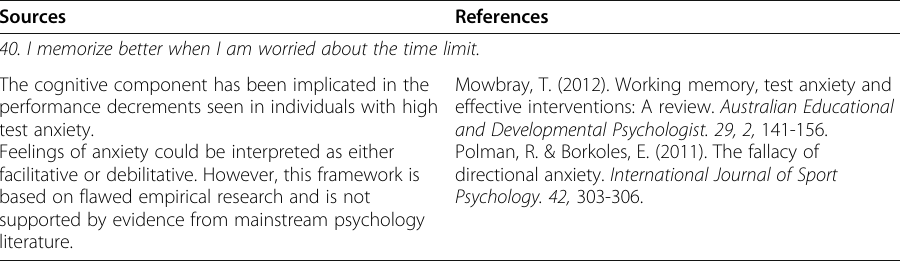
Table 4 Memory monitoring; exemplar item with the sources and references Sources